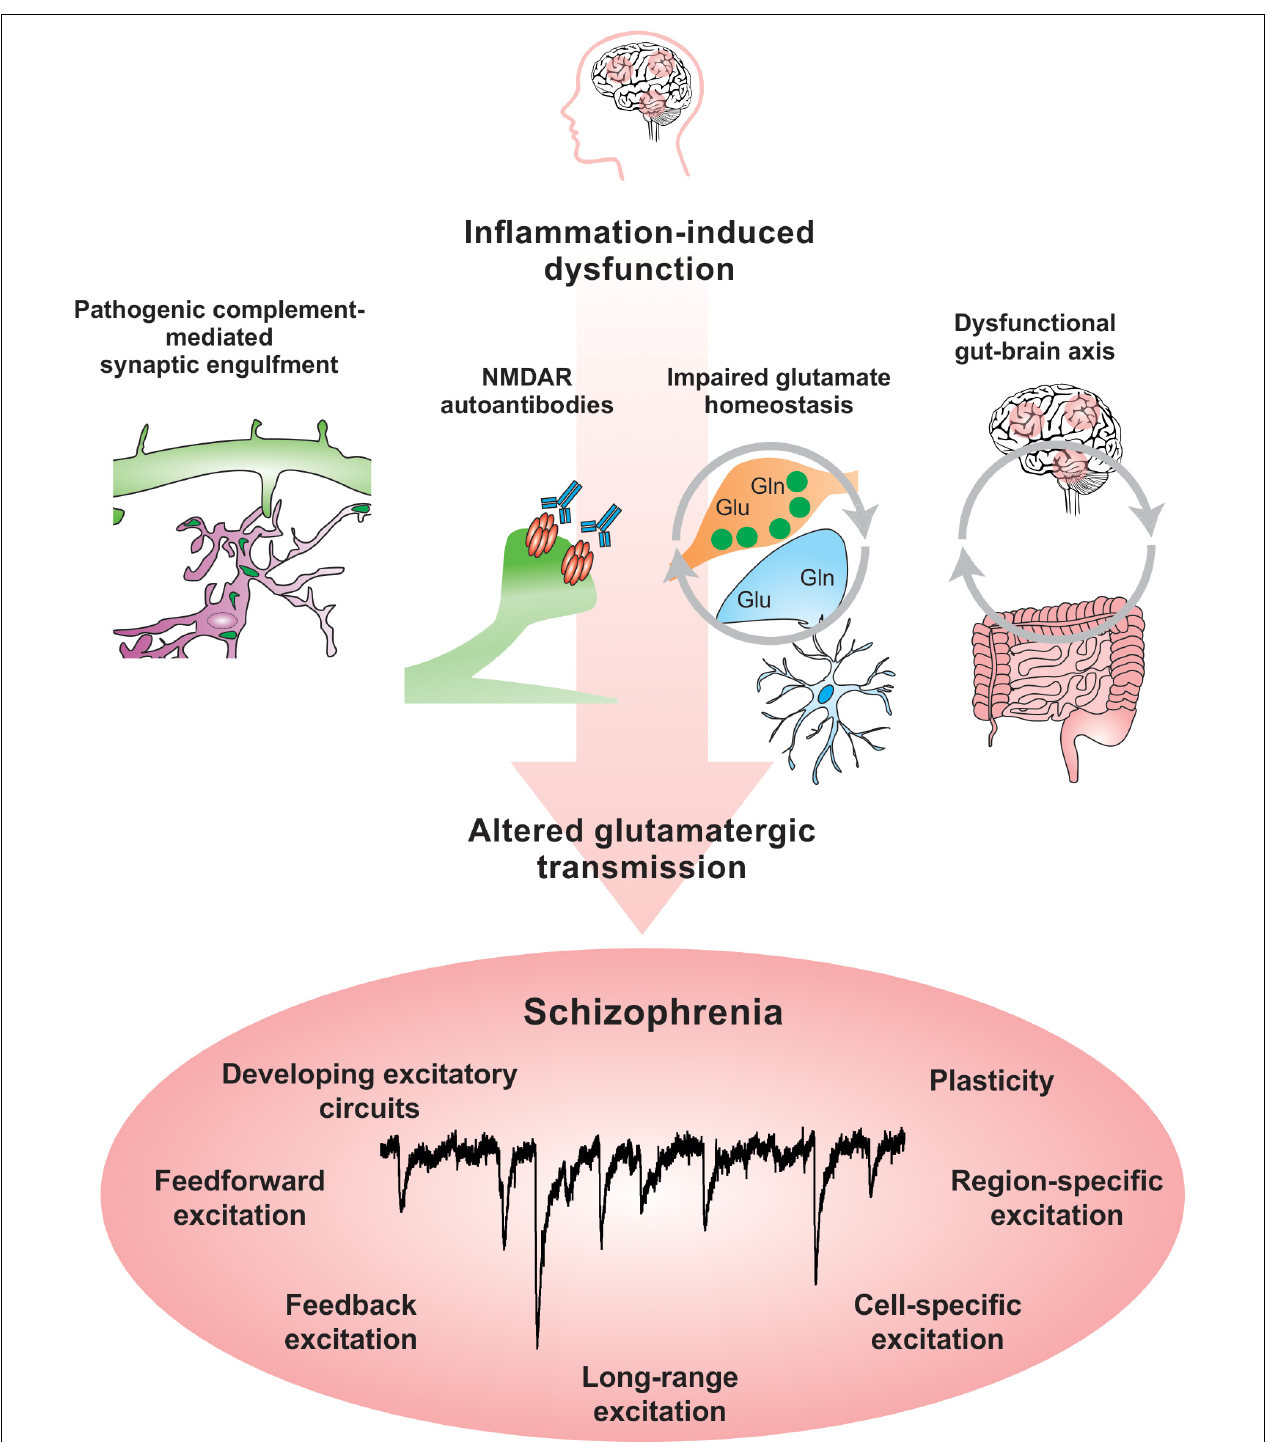
FIGURE 4 | Neuroinflammation-induced dysfunctions that alter glutamatergic transmission in SCZ. Changes in glutamatergic transmission are known to occur in SCZ. Neuroinflammation impacts excitatory circuitry in SCZ through complement-mediated engulfment of excitatory synapses, the production of autoantibodies against NMDARs, changes in glutamate homeostasis potentially mediated by alterations in astrocytes and changes in the gut-brain axis, a known regulator of glutamate synthesis that is able to impact CNS functions such as stress responses. These changes in excitatory transmission can alter brain circuitry, for example, by altering synaptic plasticity and long-range